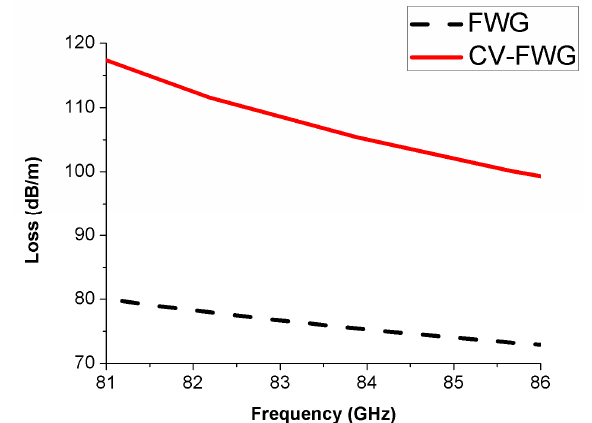
Figure 10. Transmission loss of CV-FWG and conventional FWG.